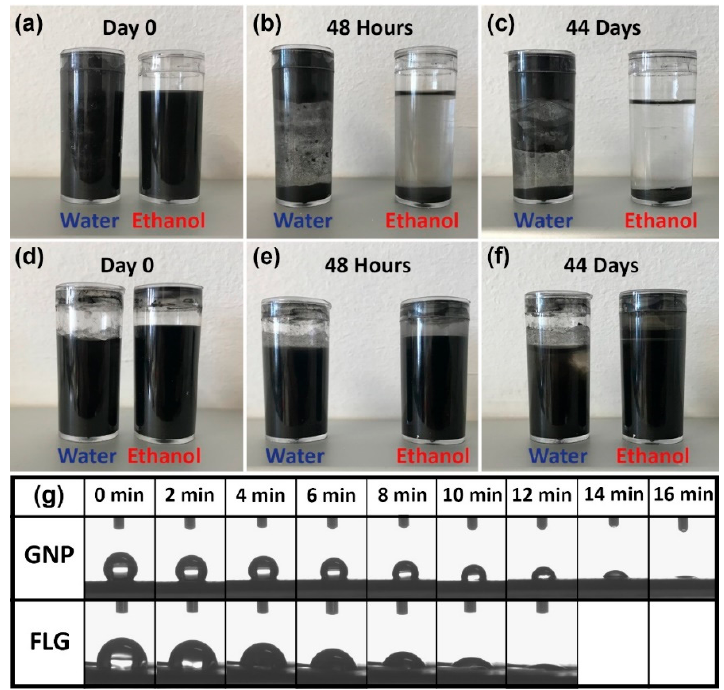
Figure 3. Dispersions of ( a – c ) GNP and ( d – f ) FLG powders with distilled water and ethanol directly after mixing, after 48 h and after 44 days, respectively; ( g ) digital pictures taken every 2 min for the water contact angle measurements of the as-prepared GNP and FLG thin films.